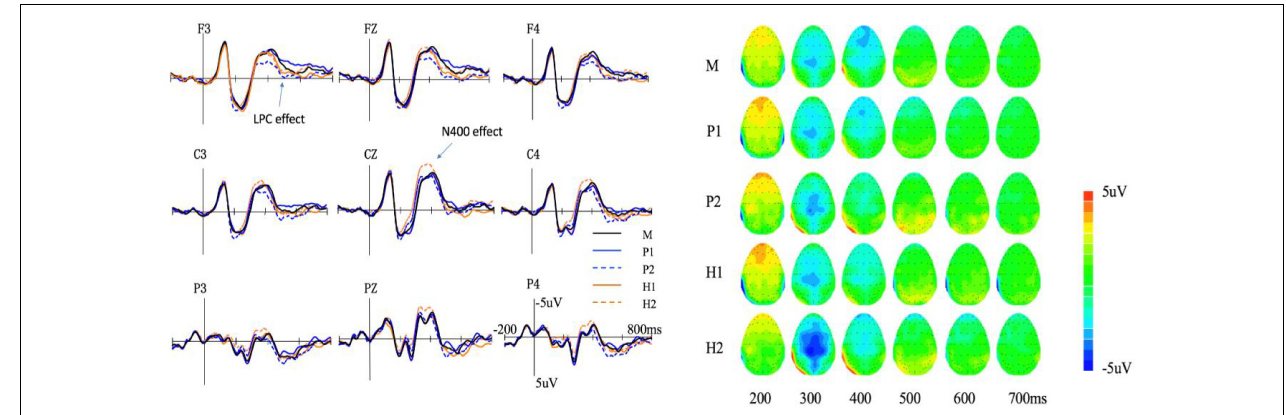
FIGURE 2 | Event-related potentials (ERP) (left) and topography (right) of the five meaning types in session A. M, monosemes; P1, the first meaning of polysemy; P2, the second meaning of polysemy; H1, the first meaning of homonym; H2, the second meaning of homonym.